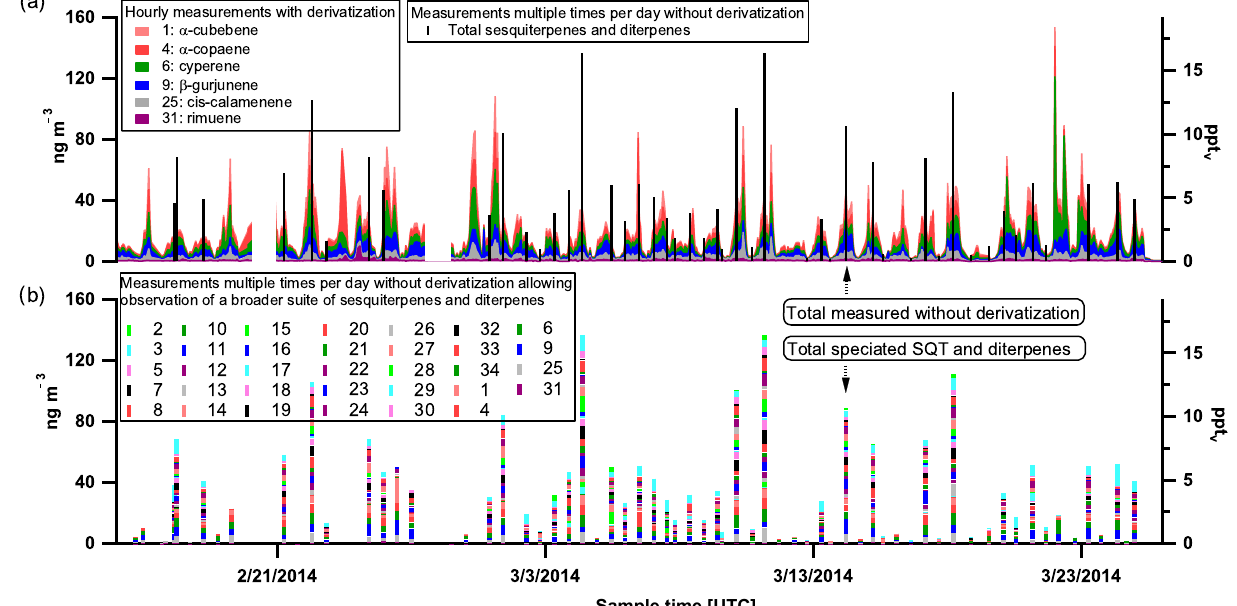
Figure 2. Wet season timeline of sesquiterpene (SQT) and diterpene species for those measured with hourly time resolution with deriva- tization (shaded colors) (a) and those measured multiple times per day at lower time resolution without derivatization (b) . Legend entries correspond to compound numbers in Table 1. Total SQTs and diterpenes quantified during runs without derivatization are overlaid in black for reference in panel (a) . Concurrent speciation shown in (b)